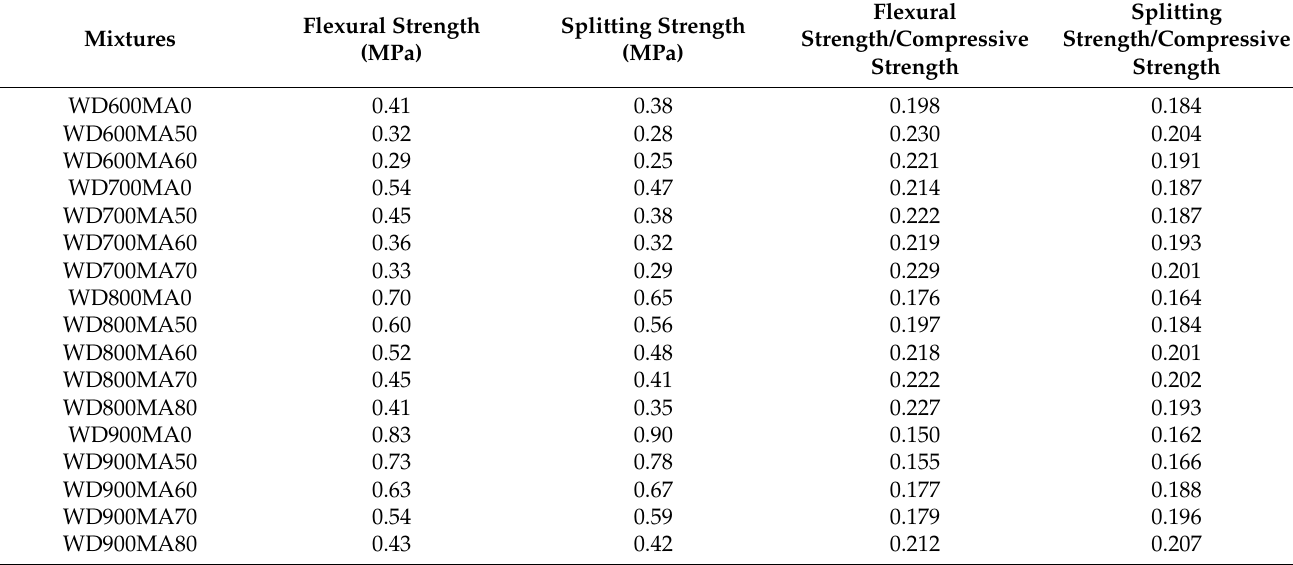
Table 6. Flexural and splitting strength of Series II